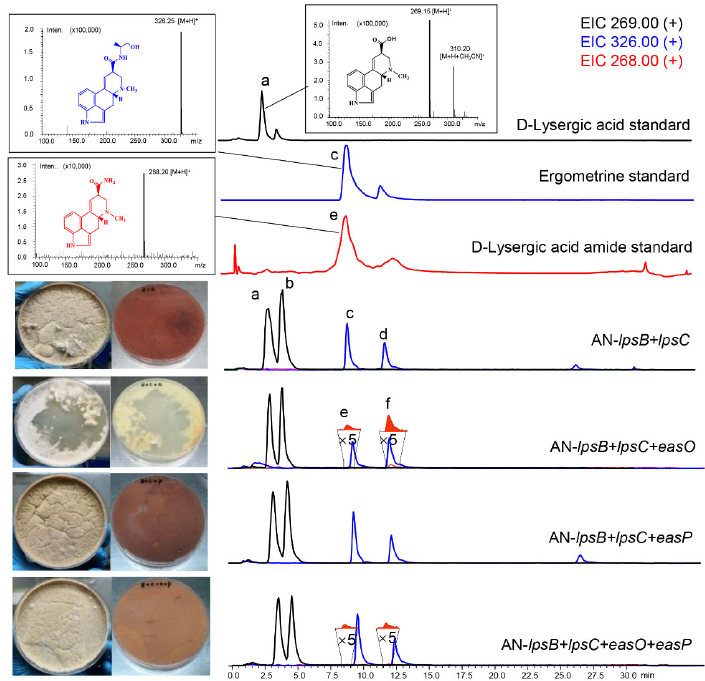
Figure 6. LC-MS analysis and morphologies of the corresponding strains. Note: Ergot alkaloids might convert into their isomers. a and b, D -lysergic acid and isomer; c and d, ergometrine and isomer; e and f, LAA and isomer. a, c and e were the standards of D -lysergic acid, ergometrine and LAA, respectively. AN- lpsB + lpsC : co-expression of lpsB and lpsC in A. nidulans host. AN- lpsB + lpsC + easO : co-expression of lpsB , lpsC and easO in A. nidulans host. AN- lpsB + lpsC + easP : co-expression of lpsB , lpsC and easP in A. nidulans host. AN- lpsB + lpsC + easO + easP : co-expression of lpsB , lpsC , easO and easP in A. nidulans host. The morphologies of different recombinants on the solid medium show the sporulation ( left ) and the color patterns ( right ) after incubation at 30 ◦ C for 5